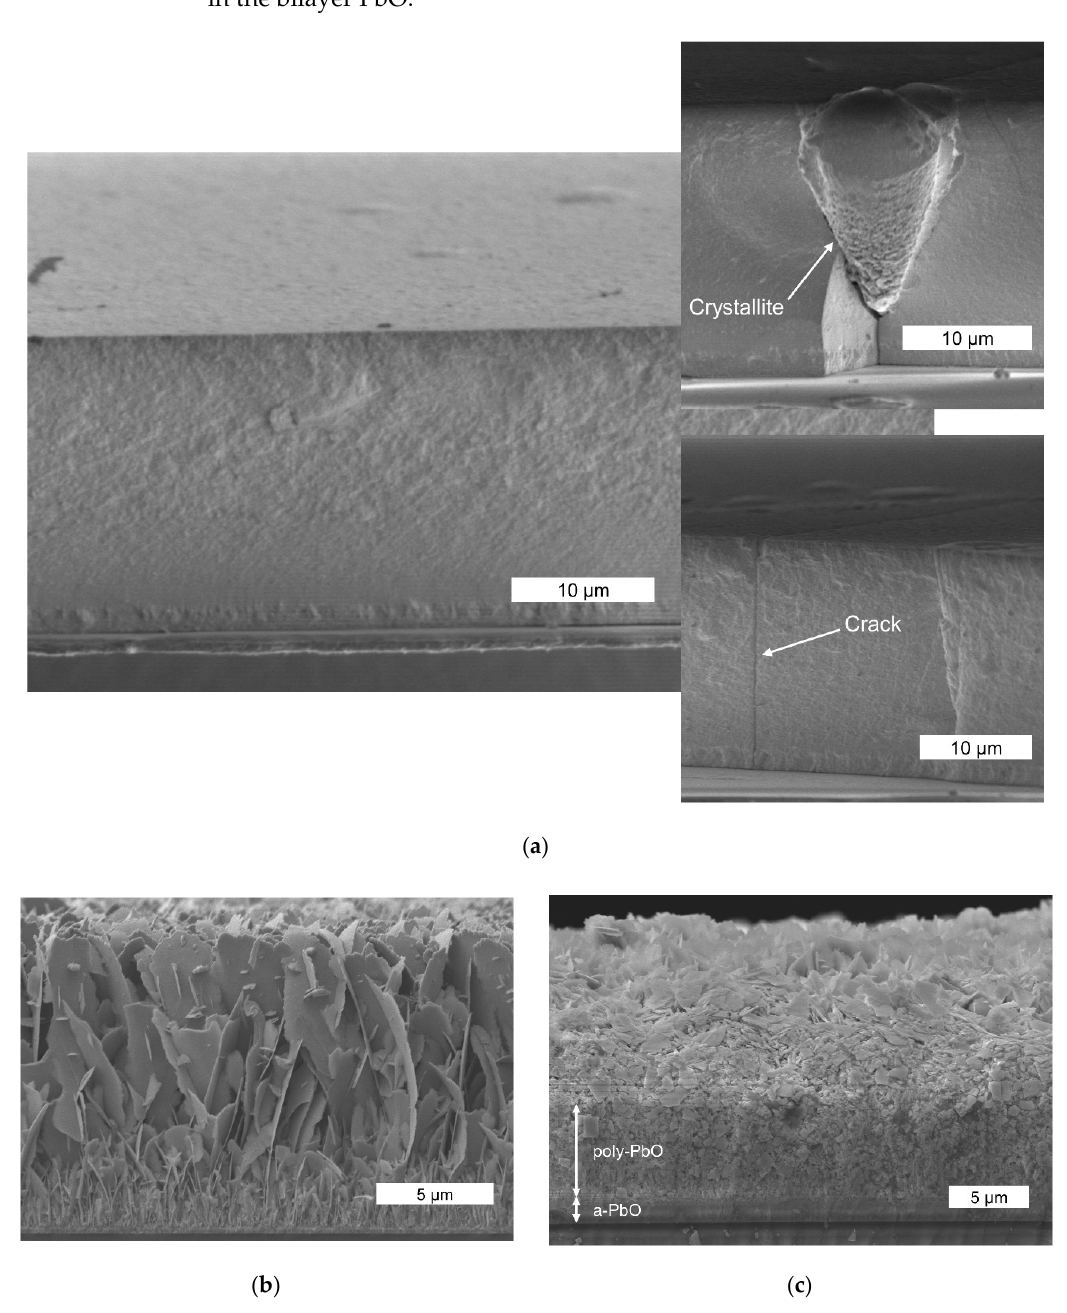
Figure 8. The SEM cross-sectional view of ( a ) a-PbO, ( b ) poly-PbO [25], and ( c ) a-PbO/poly-PbO bilayer structure [35]. The insets of Figure 9a show structural defects that appear in thick a-PbO layers. ( b ) Image adapted from Semeniuk et al. [25] with the permission of Springer Nature. ( c ) Image adapted from Grynko et al. [35] with permission of Springer